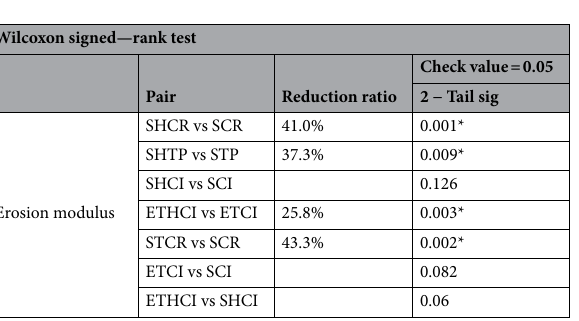
Figure 3. The values of runoff depth ( a ) and erosion modulus ( b ) from different runoff plots.